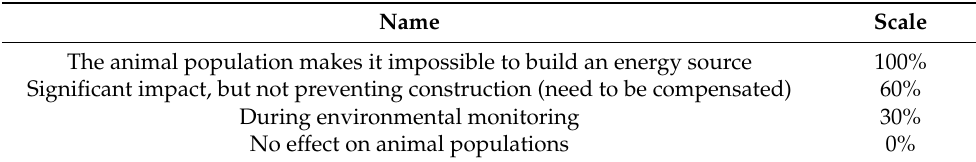
Table 3. Percentage rating scale of the sub-criterion X 4,3 —impact on animal population. Name